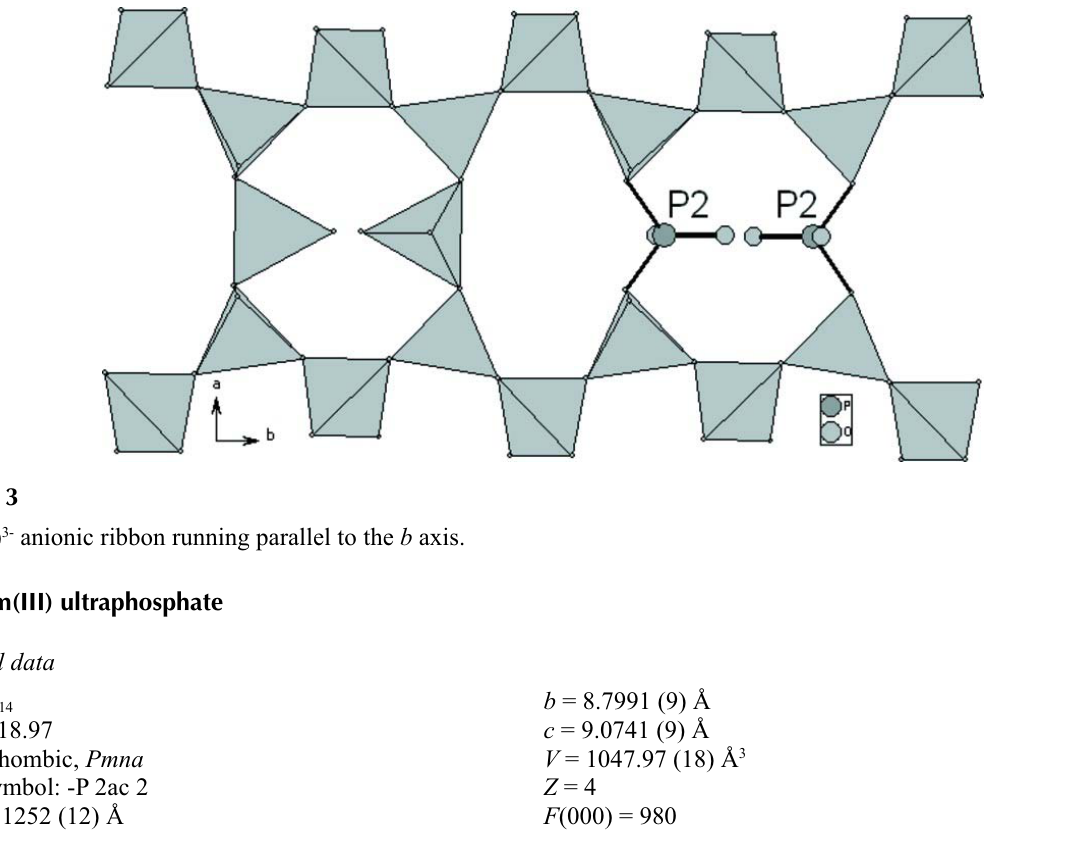
groups and the gray circles represent Ce 3+ 4